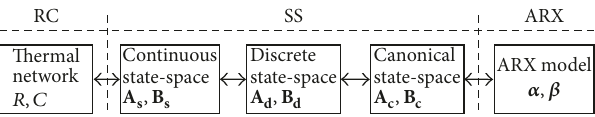
Figure 1: Transformation flow chart.